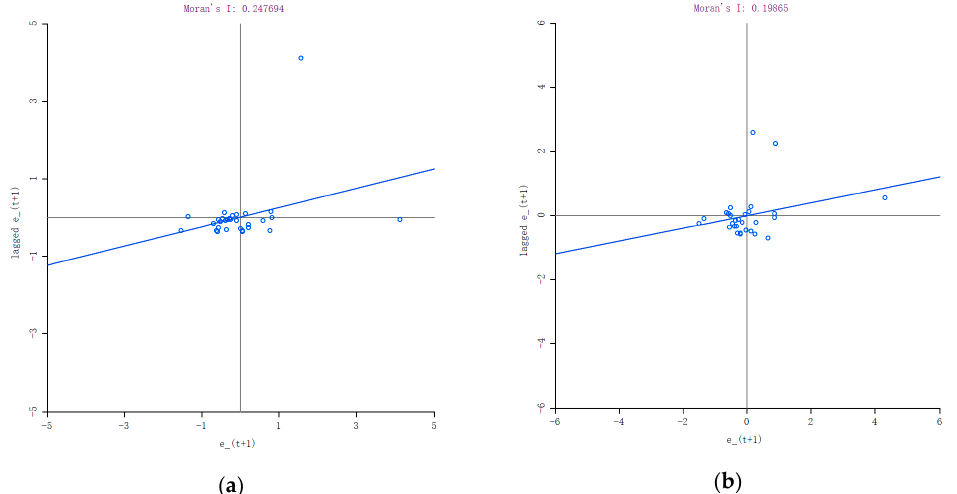
Figure 2. Overall decoupling conditions of 30 provinces in China. ( a ) The change rate of Gross Regional Product (GRP) and SO 2 emissions. ( b ) The overall decoupling indexes.